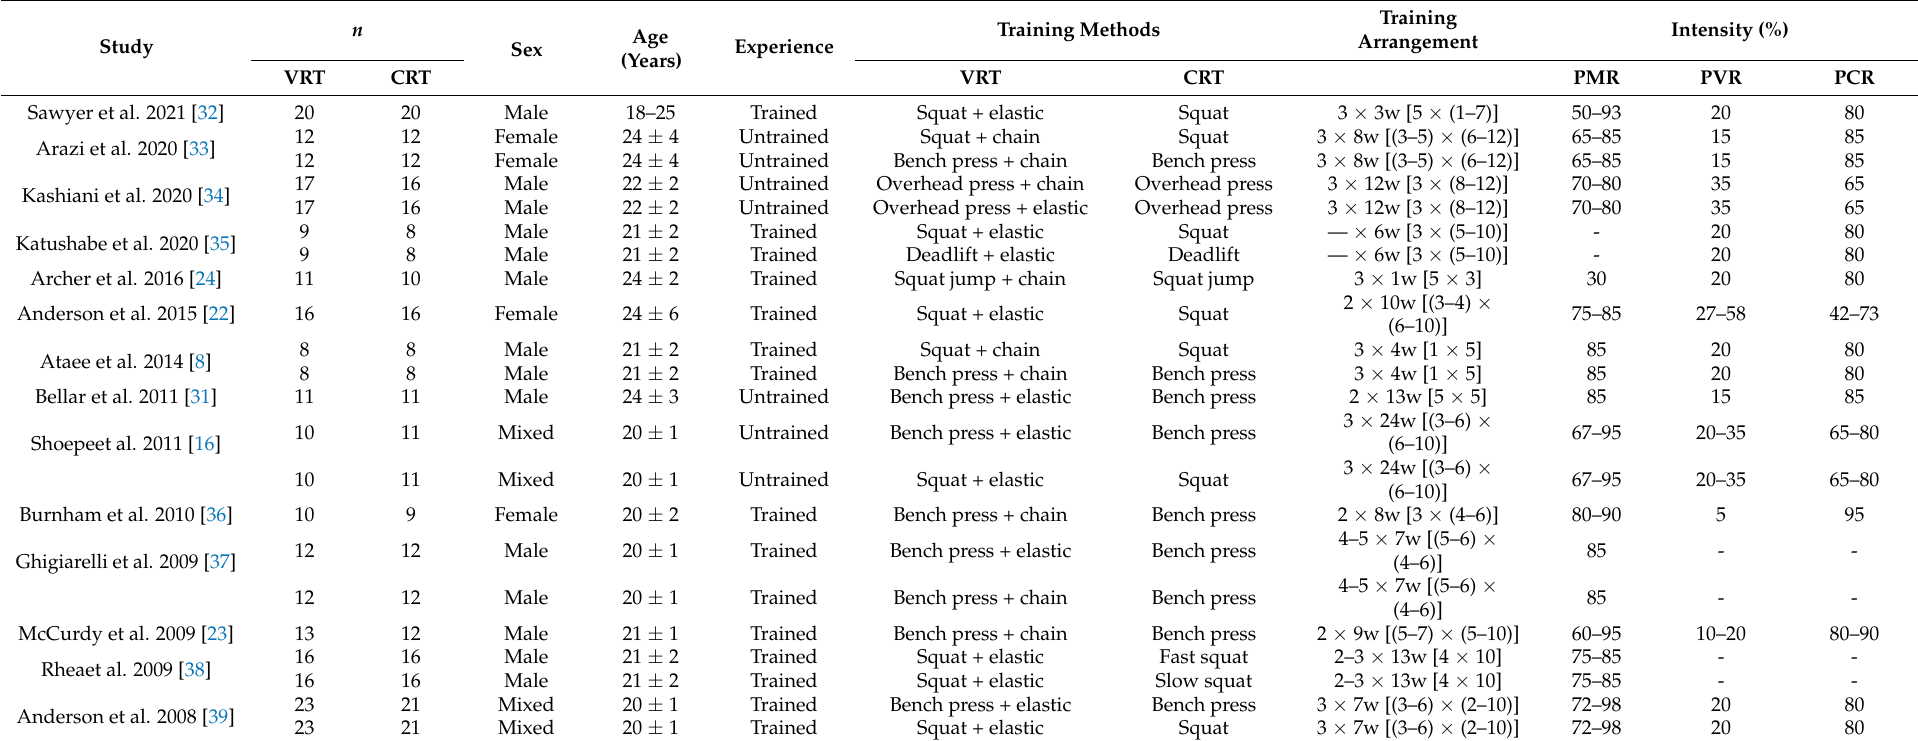
Table 1. Details of the studies included in the